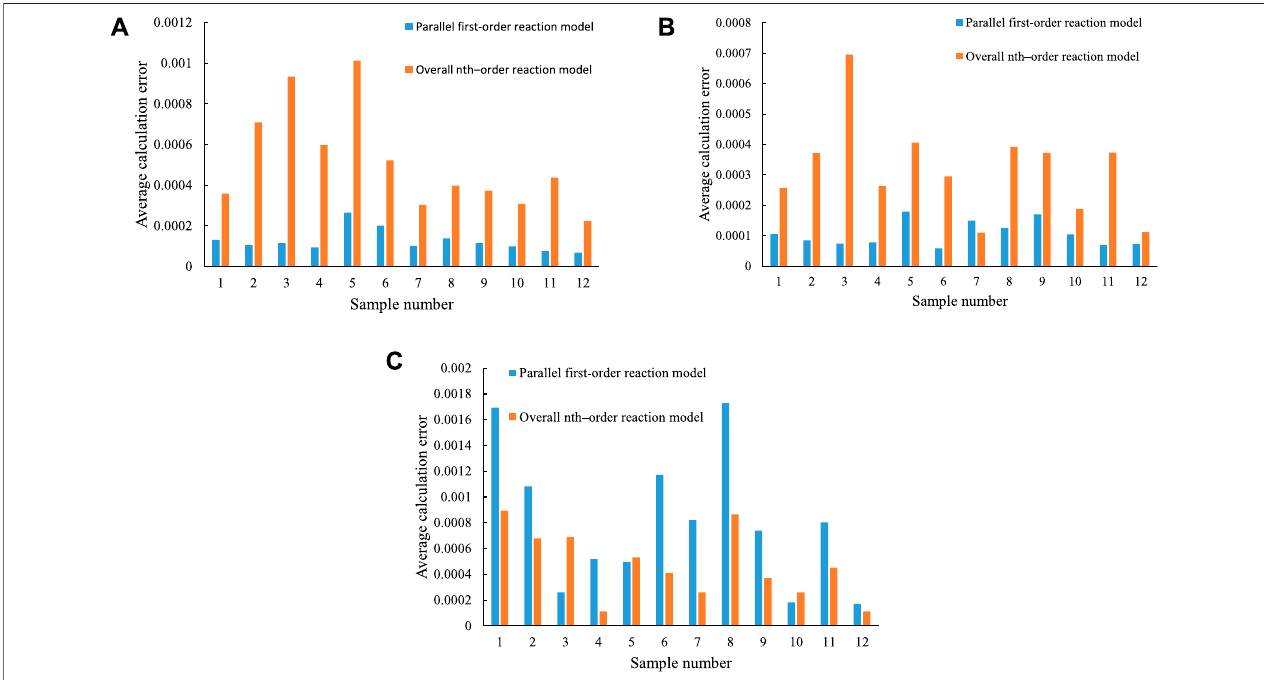
FIGURE 7 | Comparison of the average calculation errors of the parallel fi rst – order reaction model and the overall nth – order reaction model. (A) C 1 – 5 . (B) C 6 – 14 . (C) C 14+